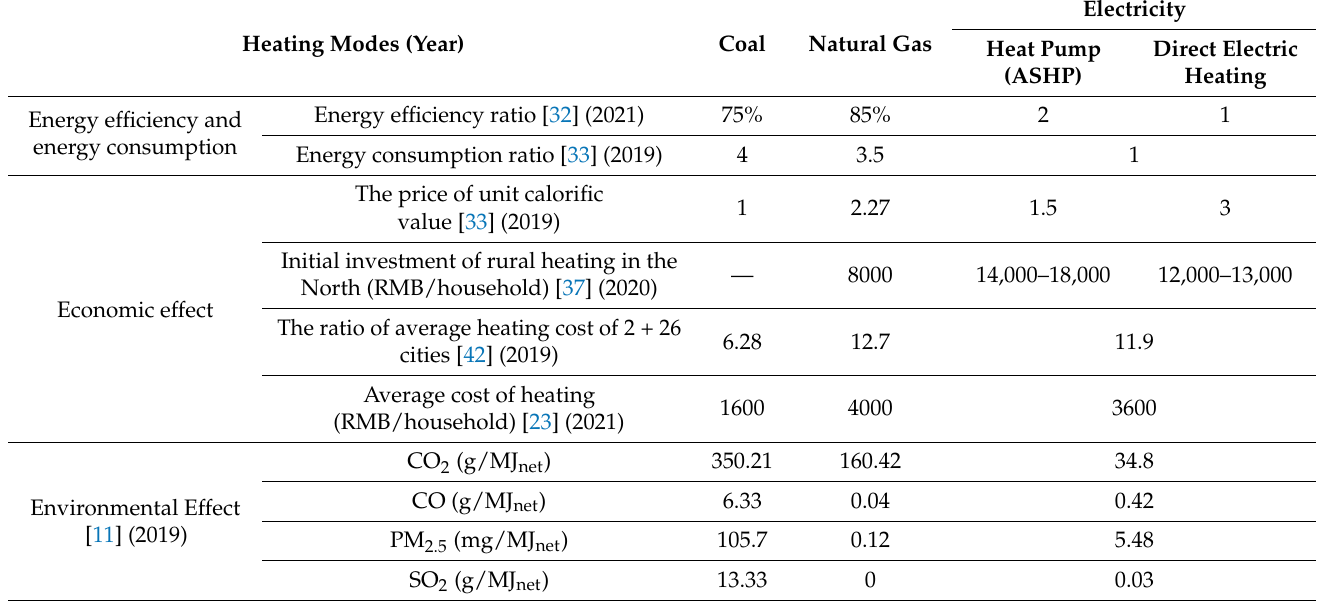
Table 1. Comparison of indicators of heating transformation in